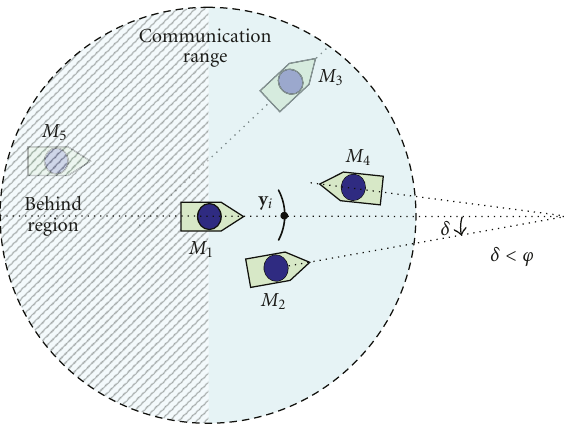
Figure 12: Illustration of the set Λ for M 1 . Only nodes M 2 and M 4 are used in the calculation of J m ( y i